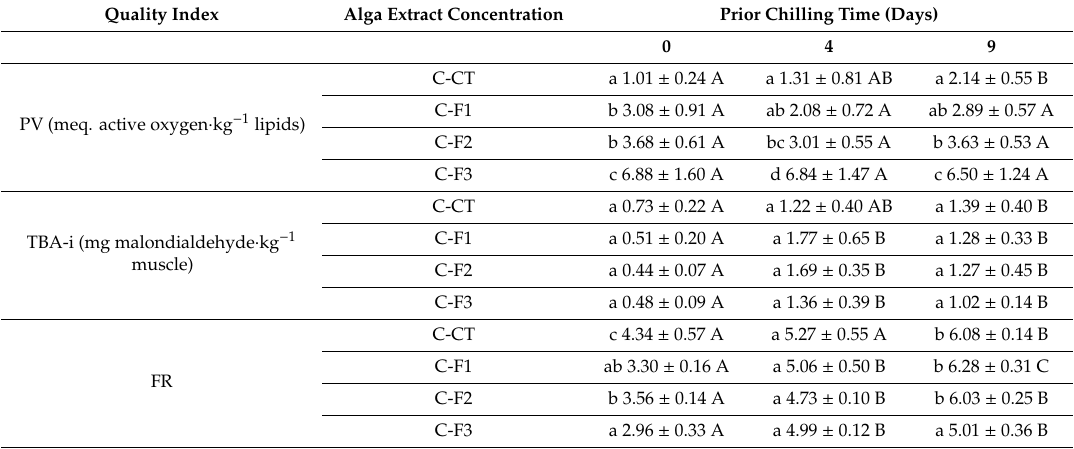
Table 1. Determination of peroxide value (PV), thiobarbitruric acid index (TBA-i) and fluorescence ratio (FR) in canned mackerel packaged with di ff erent alga extract concentrations and previously subjected to di ff erent chilling times. Quality